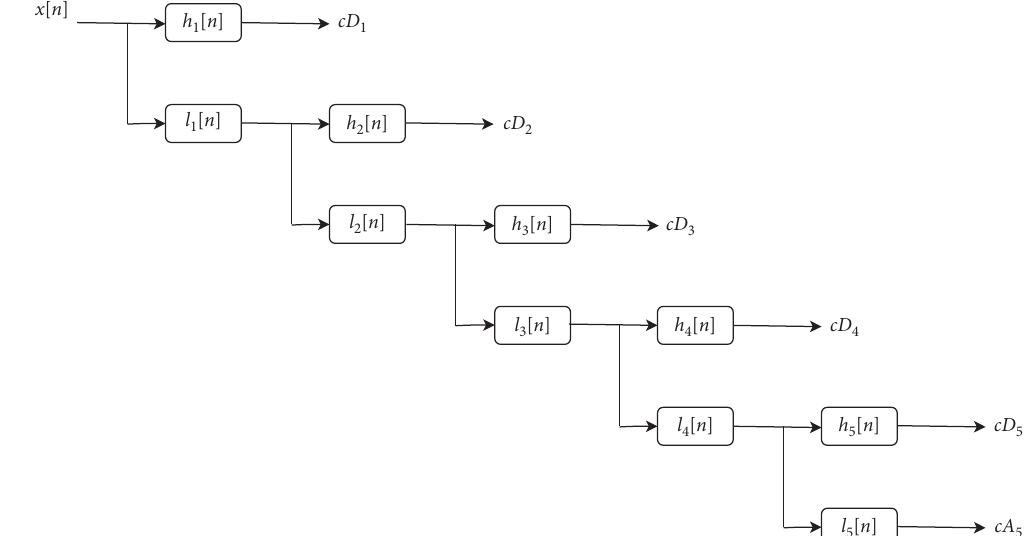
Figure 2: Signal decomposition using SWT at level five ( h i : high-level features at decomposition level i ; l i : low-level features at de- composition level i ; cD i : detail coefficients at decomposition level i ; cA 5 : approximation coefficients at decomposition level